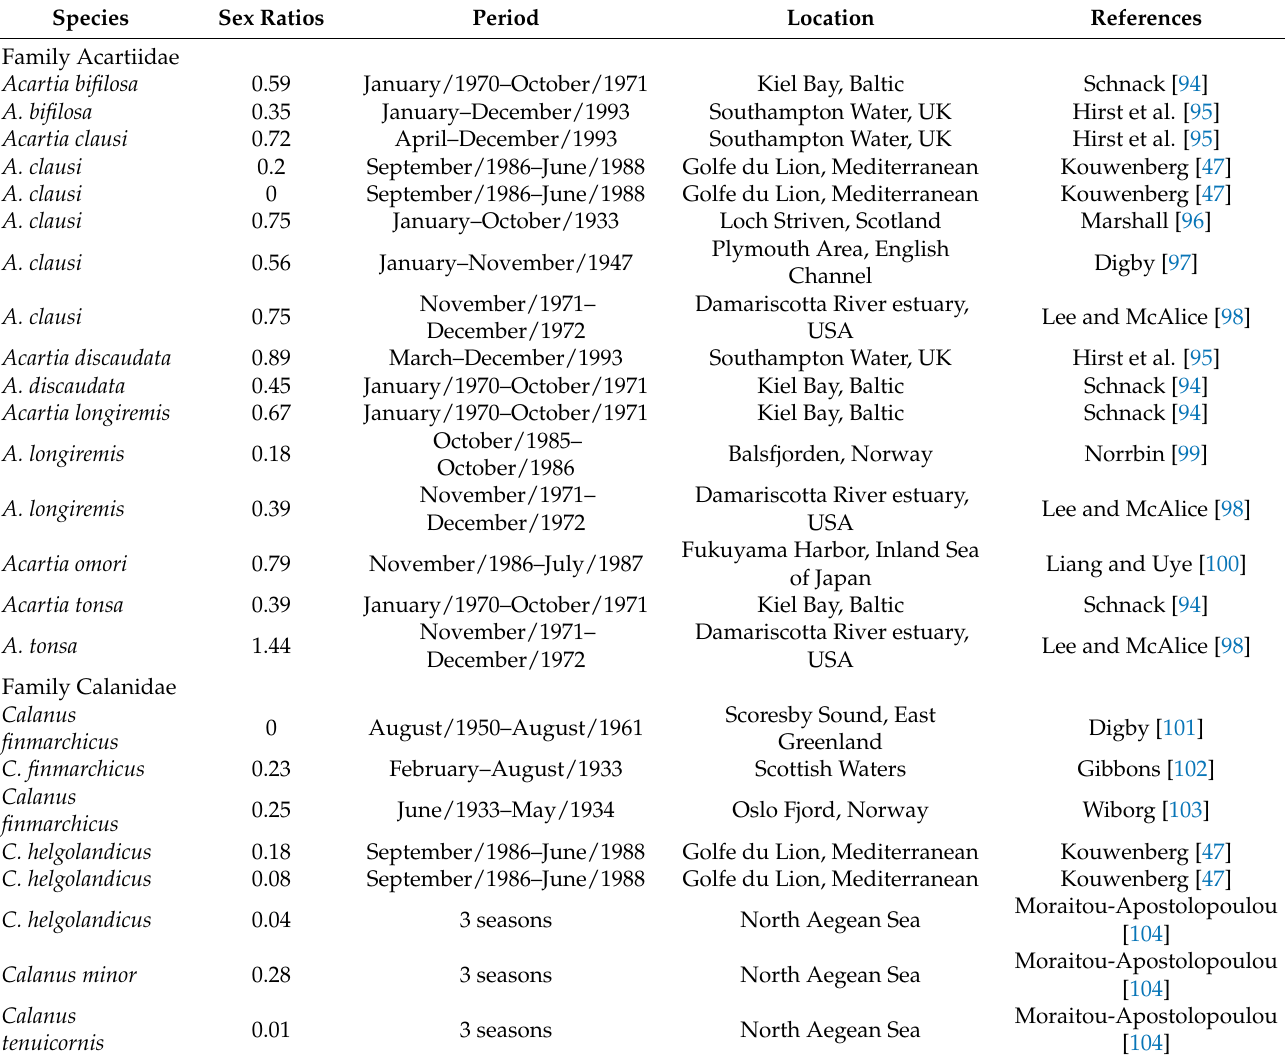
Table 4. Field adult sex ratio of planktonic copepods (adopted from Hirst and Kiørboe [93]). Species Sex Ratios Period